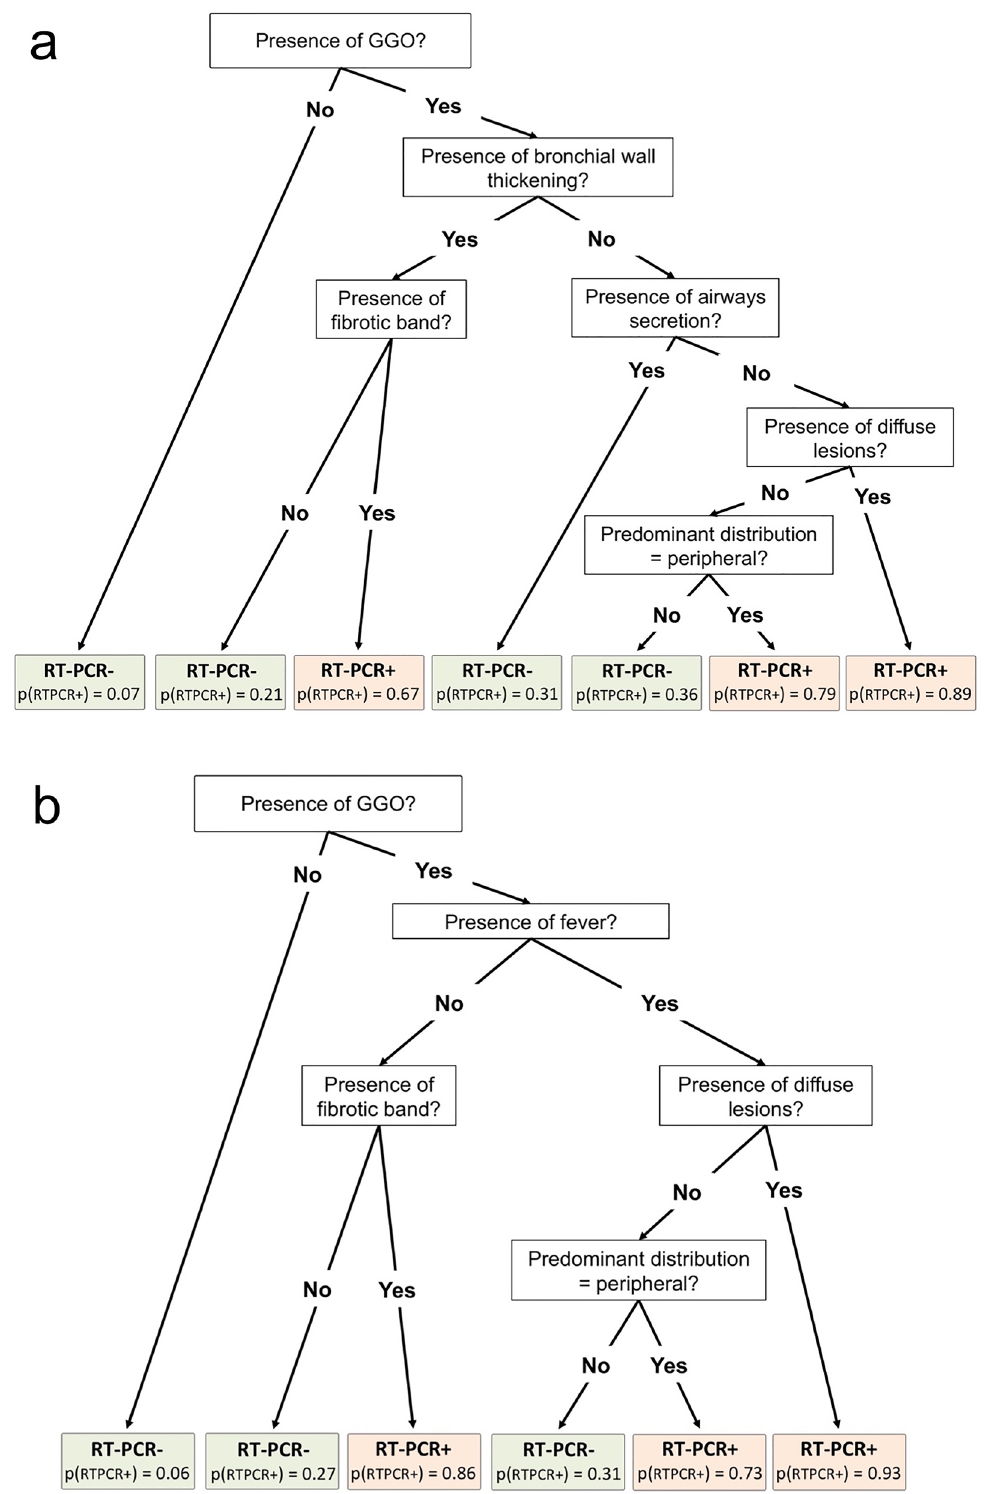
Figure 3. Final classification and regression tree (CART) models built with ( a ) radiological variables alone (with the highest performances in the validation cohort) and ( b ) clinical radiological variables. GGO ground- glass opacities, p(RT-PCR +) probability for a positive